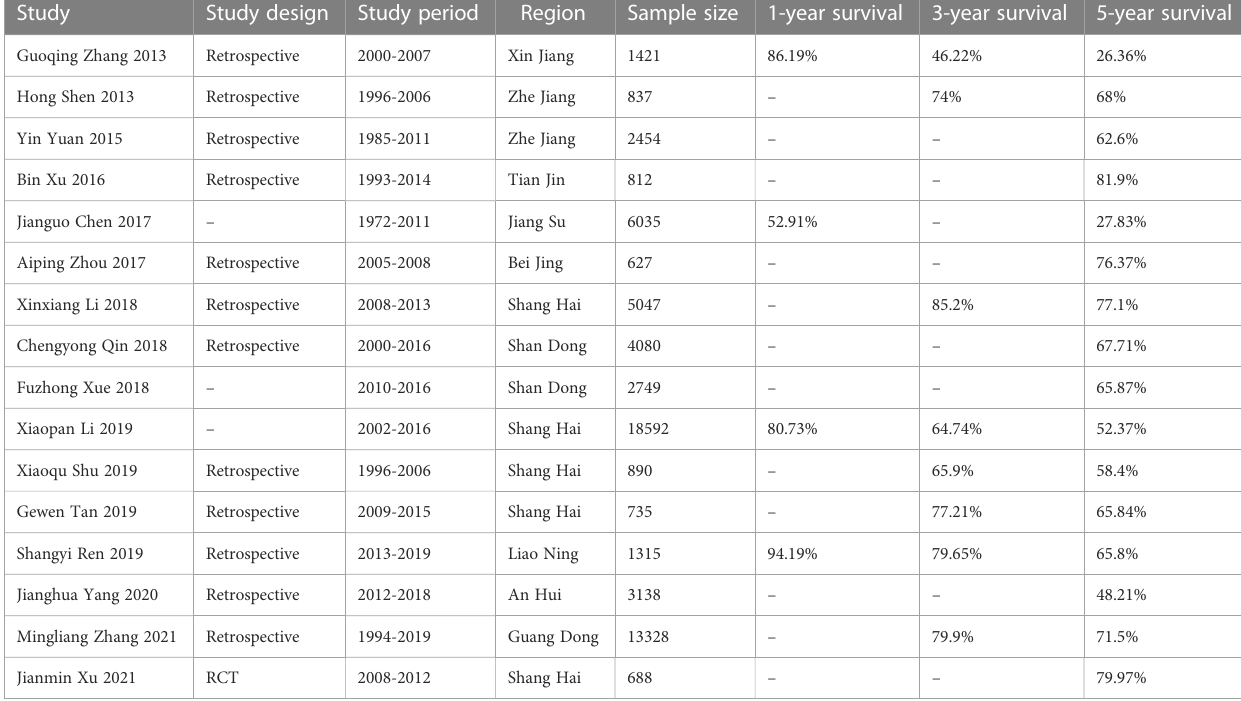
TABLE 1 Characteristics of Included